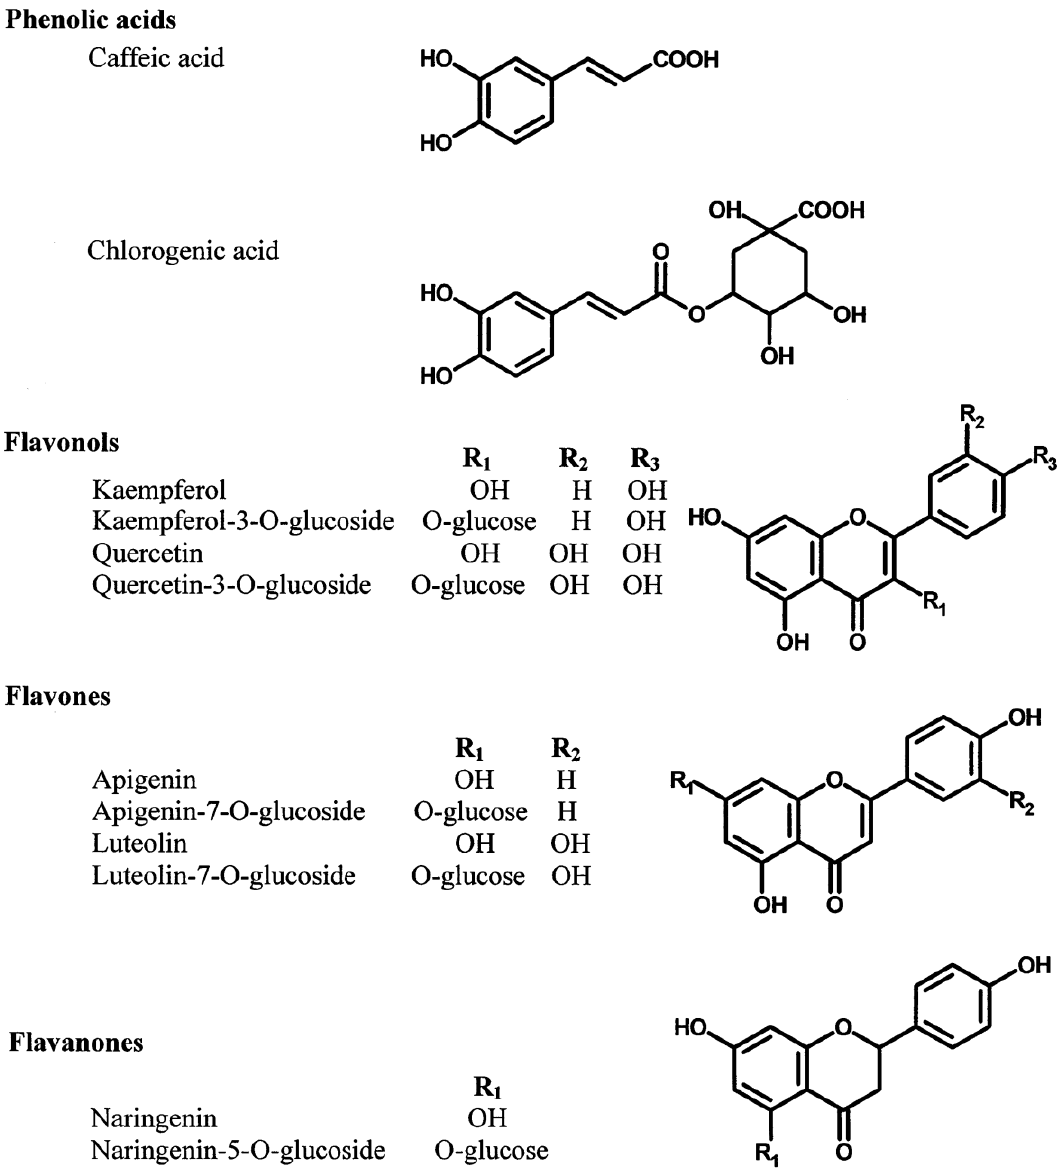
Figure 3. Chemical structures of the compounds identified by TLC (reprinted with permission from Ref. [18], Czinner, E. et al., J. Ethnopharm , 2000).